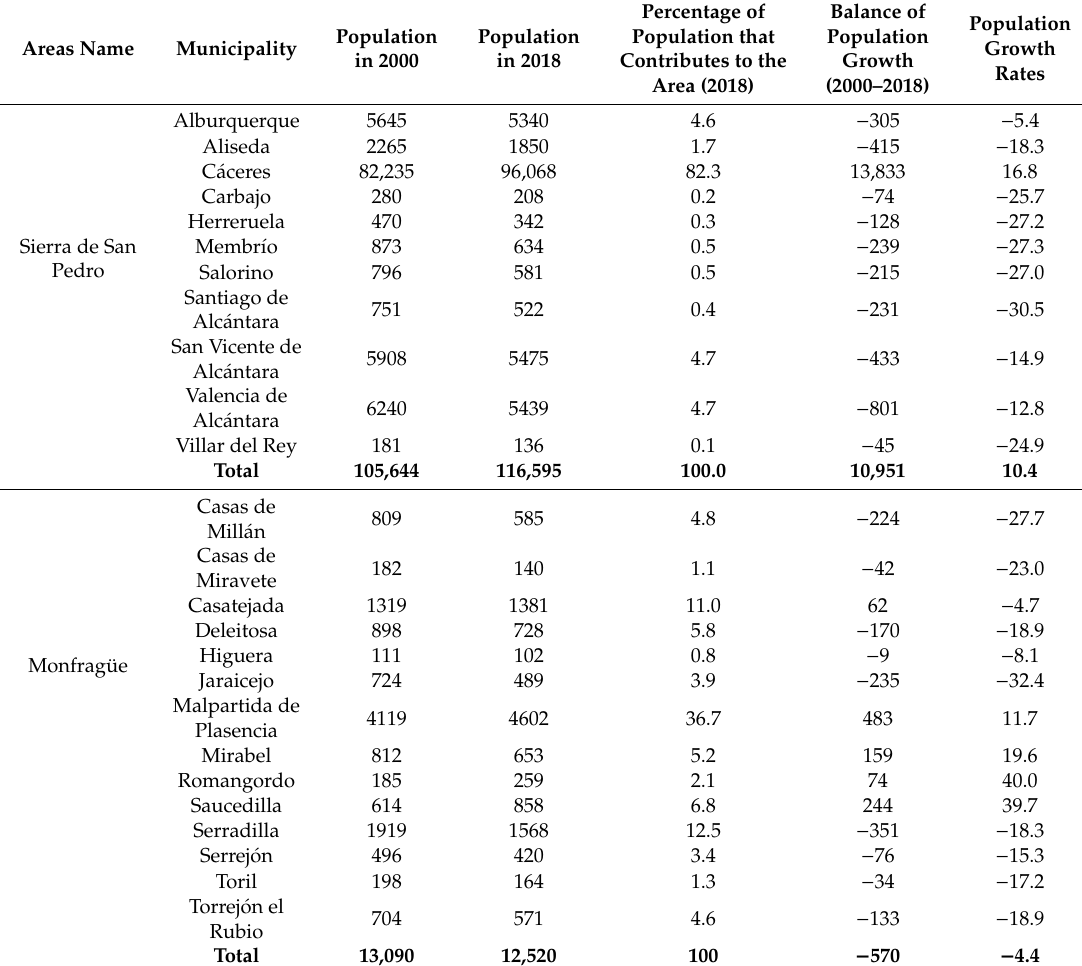
Table 3. Population